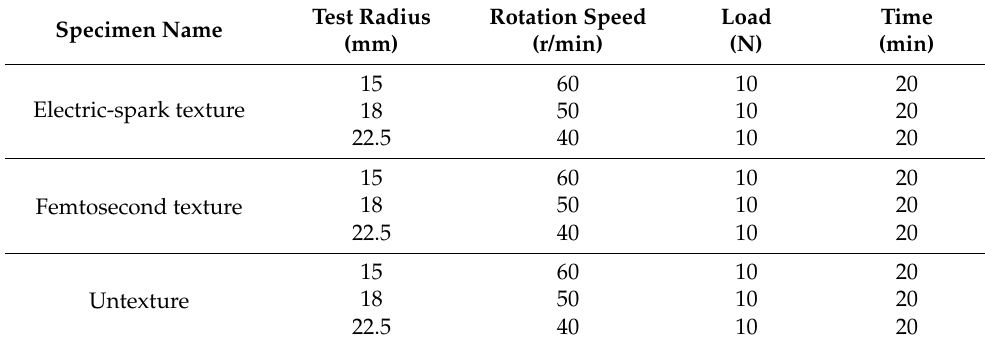
Table 4. Experimental conditions for rotation